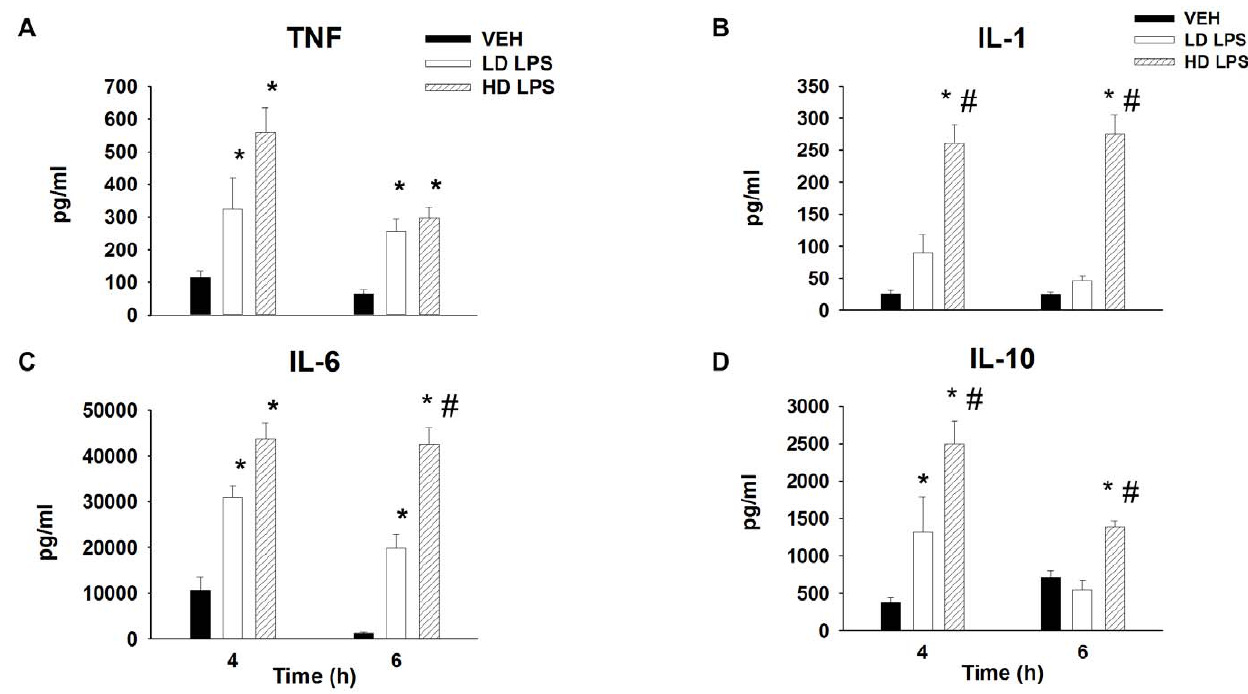
Figure 2. Plasma cytokine levels following vehicle and LPS treatment. Plasma concentration of tumor necrosis factor-alpha (TNF; Panel A), interleukin-1 b (IL-1; Panel B), interleukin-6 (IL-6; Panel C) and interleukin-10 (Panel D; IL-10) 4- and 6-hours following vehicle (VEH), low-dose LPS (LD LPS; 1 m g/gBW), and high-dose LPS (HD LPS; 10 m g/gBW) treatment in chronically catheterized conscious C57/Bl6J mice, Data are expressed as mean 6 SEM. * p , 0.05 vs. VEH, # p , 0.05 vs. LD LPS.